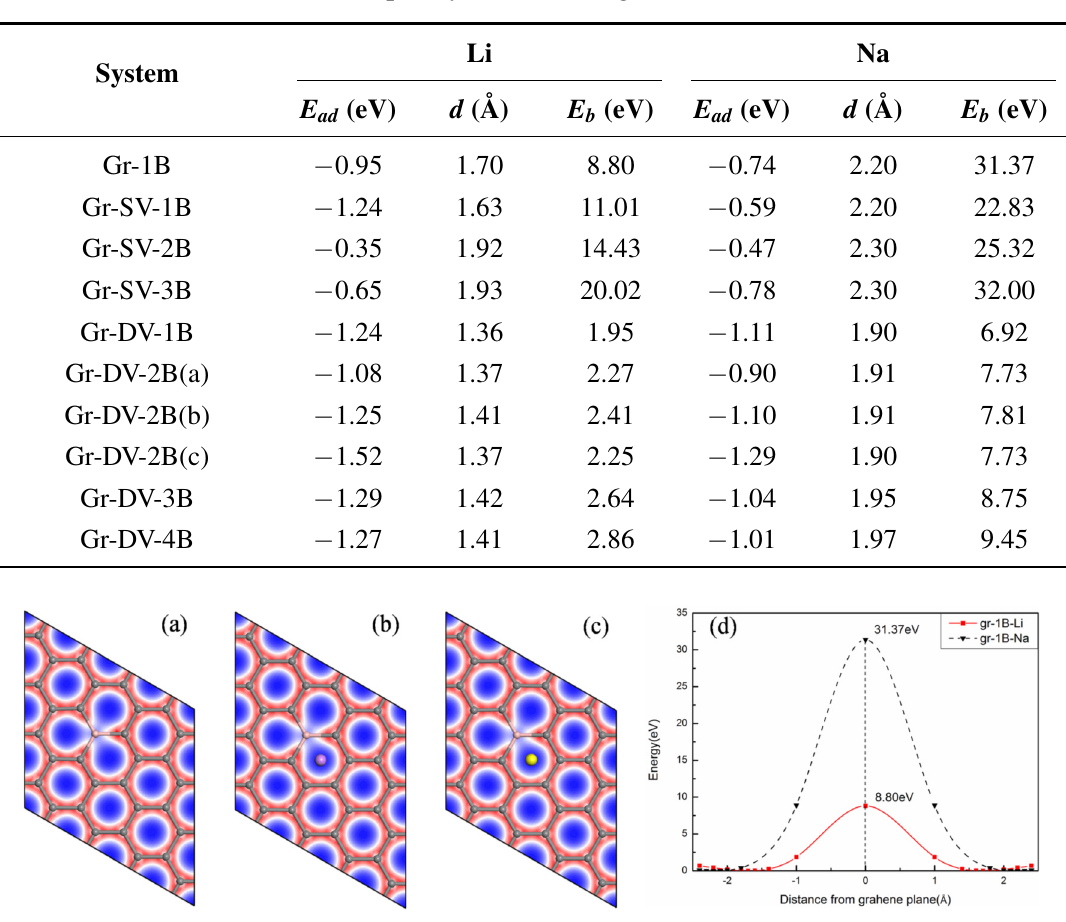
Figure 3. Distribution of the total electronic charge density for B-doped graphene: ( a ) without; ( b ) with Li; ( c ) with Na and ( d ) corresponding diffusion barriers for Li and